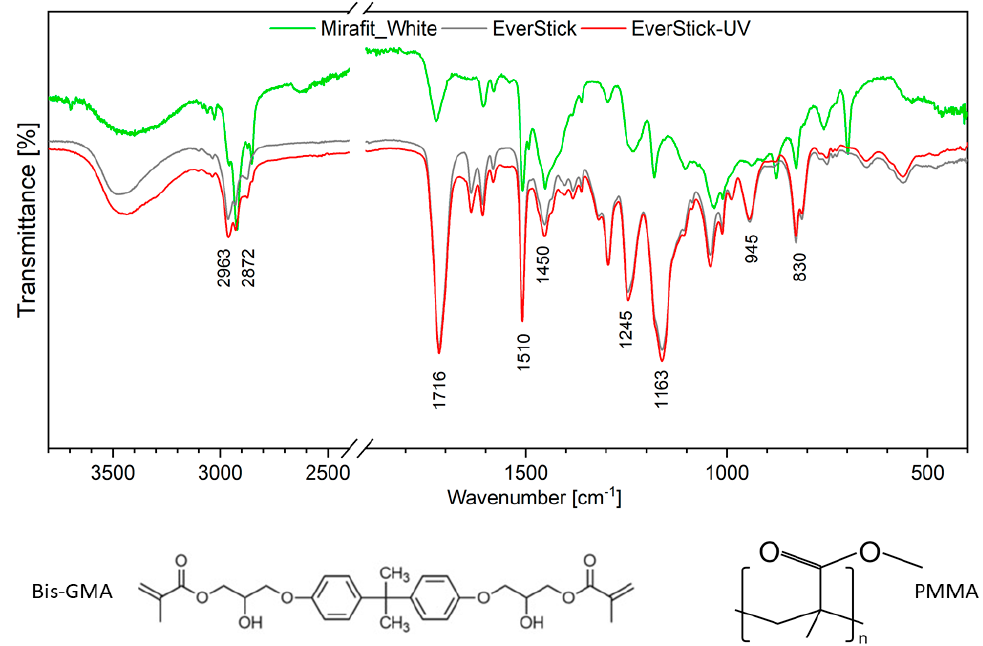
Figure 6. Fourier-transformed mid-infrared spectra of neat EverStick post, UV light-cured EverStick post, Mirafit White and GC Fibre post ( top ) and the structural formula of bisphenol A–glycidyl methacrylate (bis–GMA) ( bottom left ) and poly (methyl methacrylate) PMMA ( bottom right ).